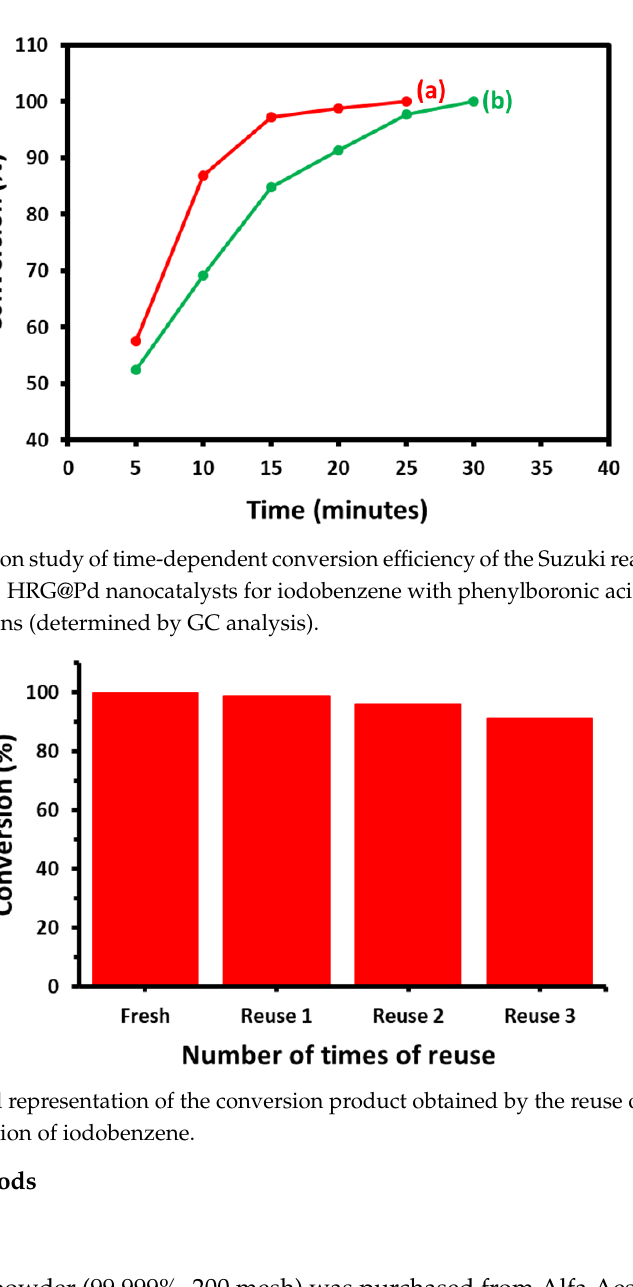
Figure 12. Time-dependent conversion efficiency of the Suzuki reaction employing NDG@Pd for various substrates (( a ) iodobenzene, ( b ) bromobenzene, and ( c ) chlorobenzene) with phenylboronic acid under aqueous and aerobic conditions (determined by gas chromatography (GC) analysis).